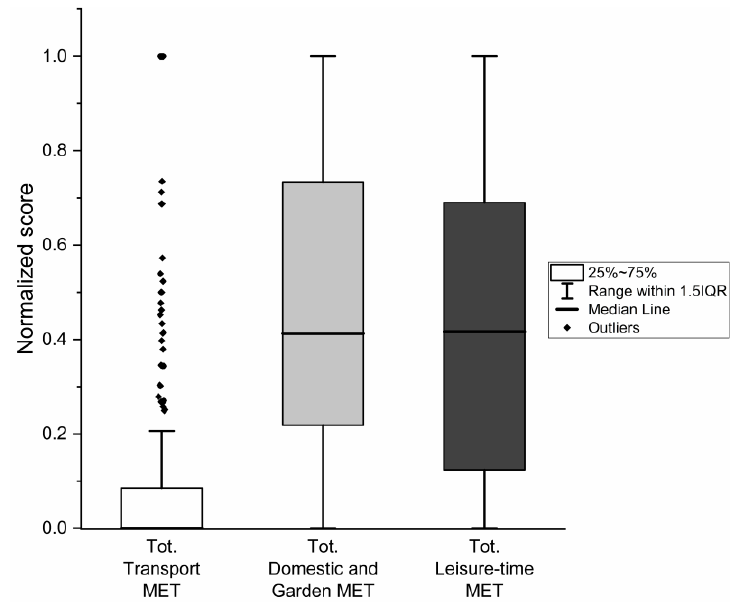
Figure 1. Box plots representing normalized distribution of IPAQ domains.